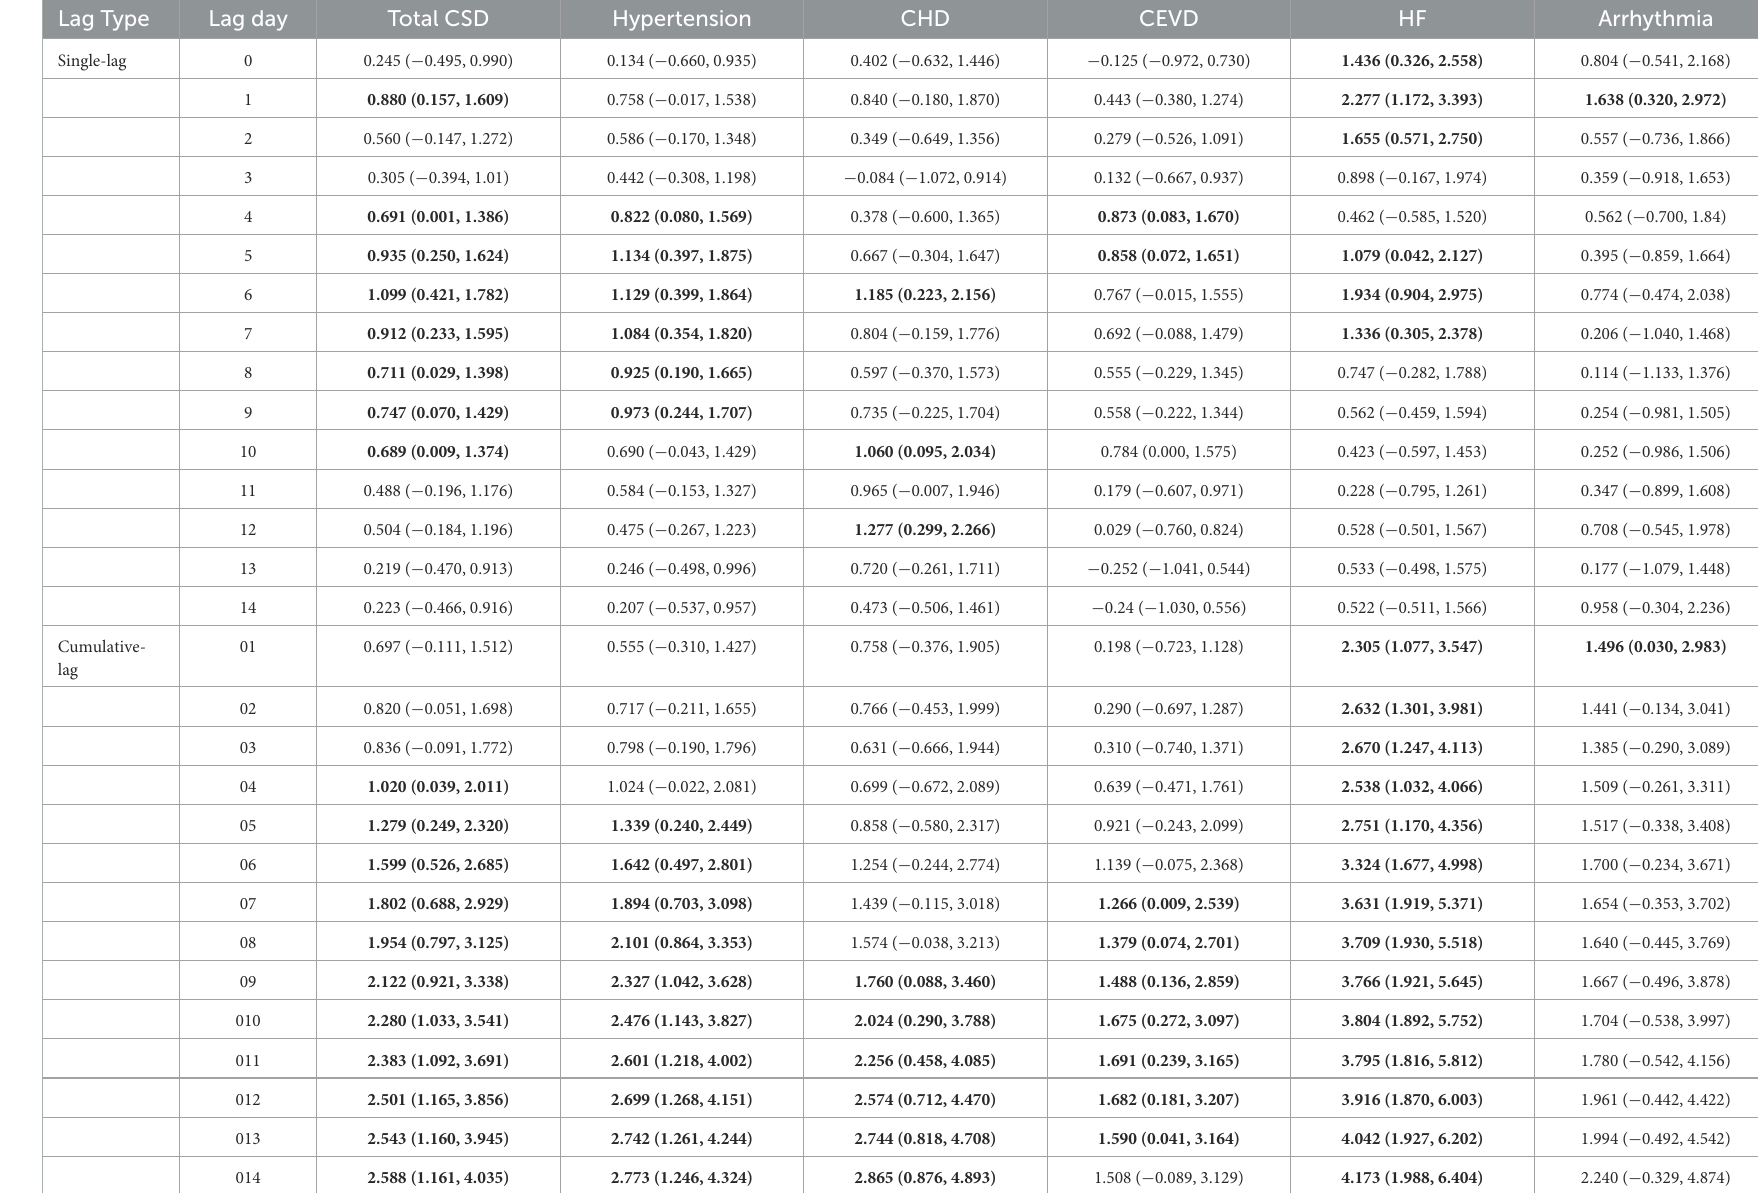
TABLE 2 Percent changes and 95% confidence intervals (CIs) of daily hospital admissions for total and cause-specific circulatory system diseases by each 10 µ g/m 3 increase of PM 2.5 concentrations at different lag structures in the single-pollutant